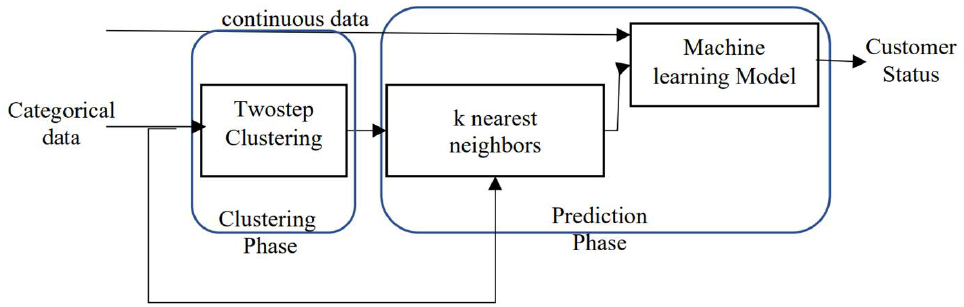
Figure 1. The proposed Model 2 based on k-nearest neighbors and two-step clustering.